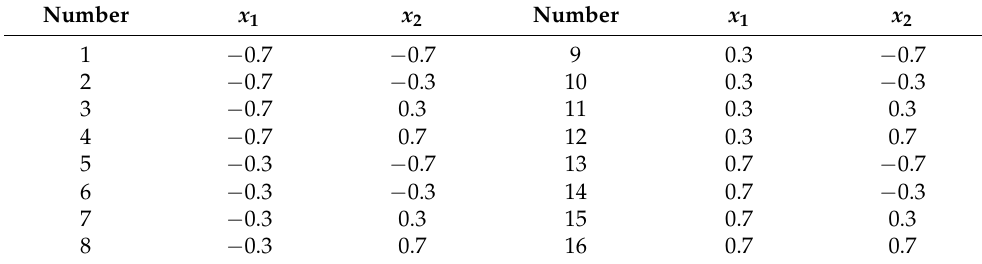
Table 2. The test sample points.